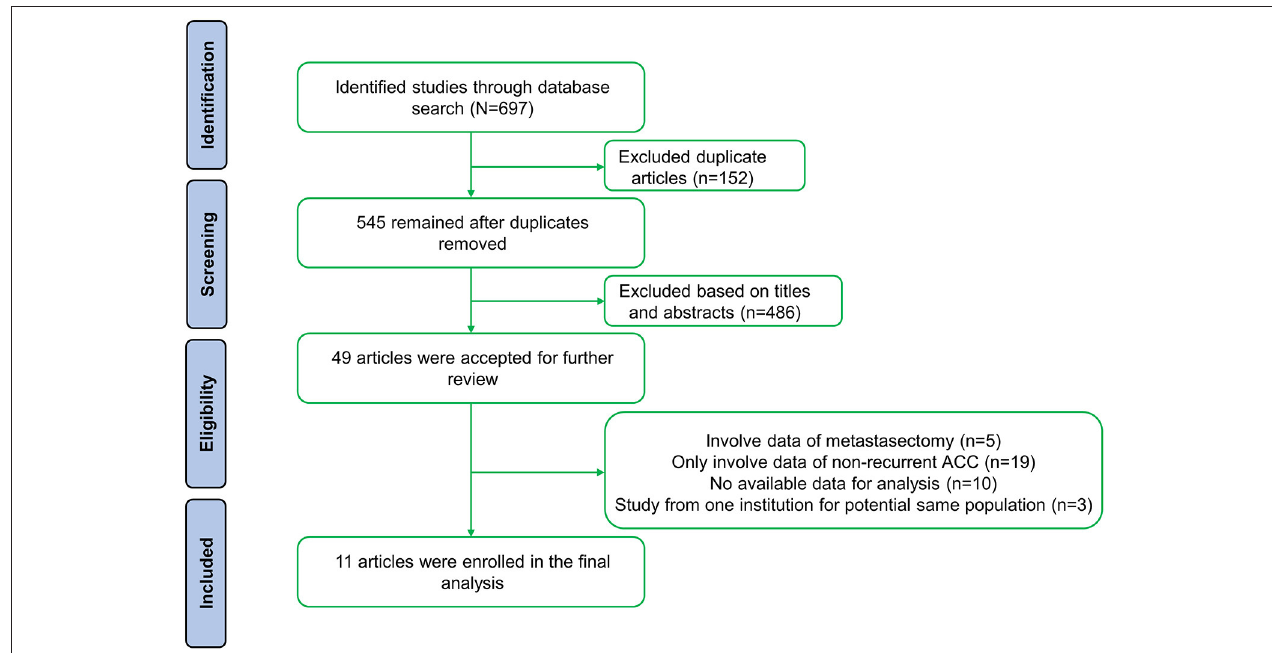
FIGURE 1 | Flow chart of the study search and selection.